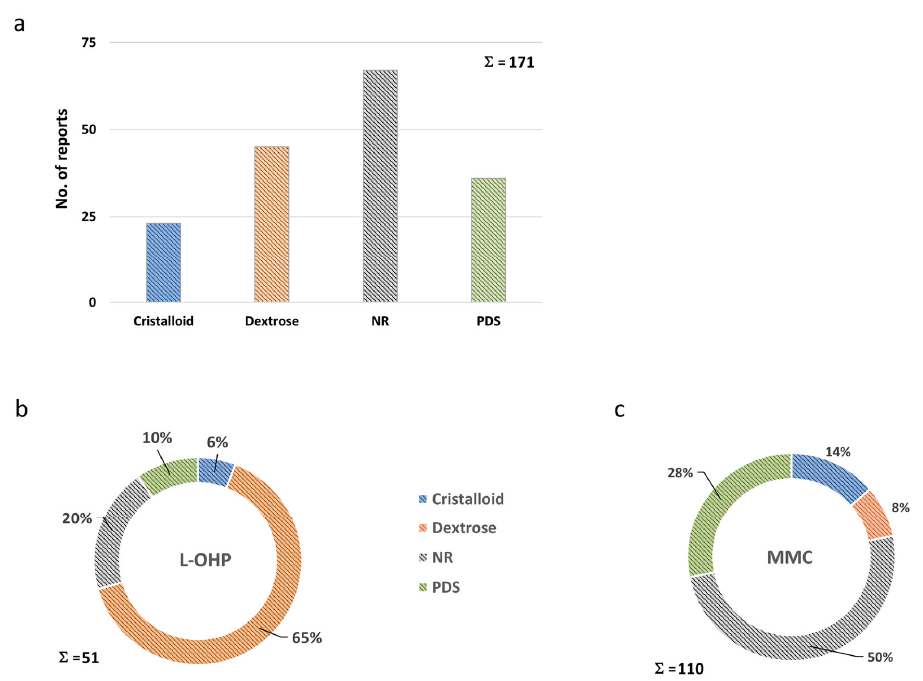
Figure 10. Overview of drug diluents: ( a ) Bar chart of records reporting the use of crystalloid, dextrose and peritoneal dialysis solutions during HIPEC or else with lacking information (NR). Detailed information on perfusion solutions is available in Tables S1–S8. ( b ) Percentages of records among L-OHP single-agent or combination treatments. ( c ) Percentages of records among MMC single-agent or combination treatments. Abbreviations used: L-OHP (oxaliplatin); MMC (mitomycin c); PDS (peritoneal dialysis solution); and NR (not reported).